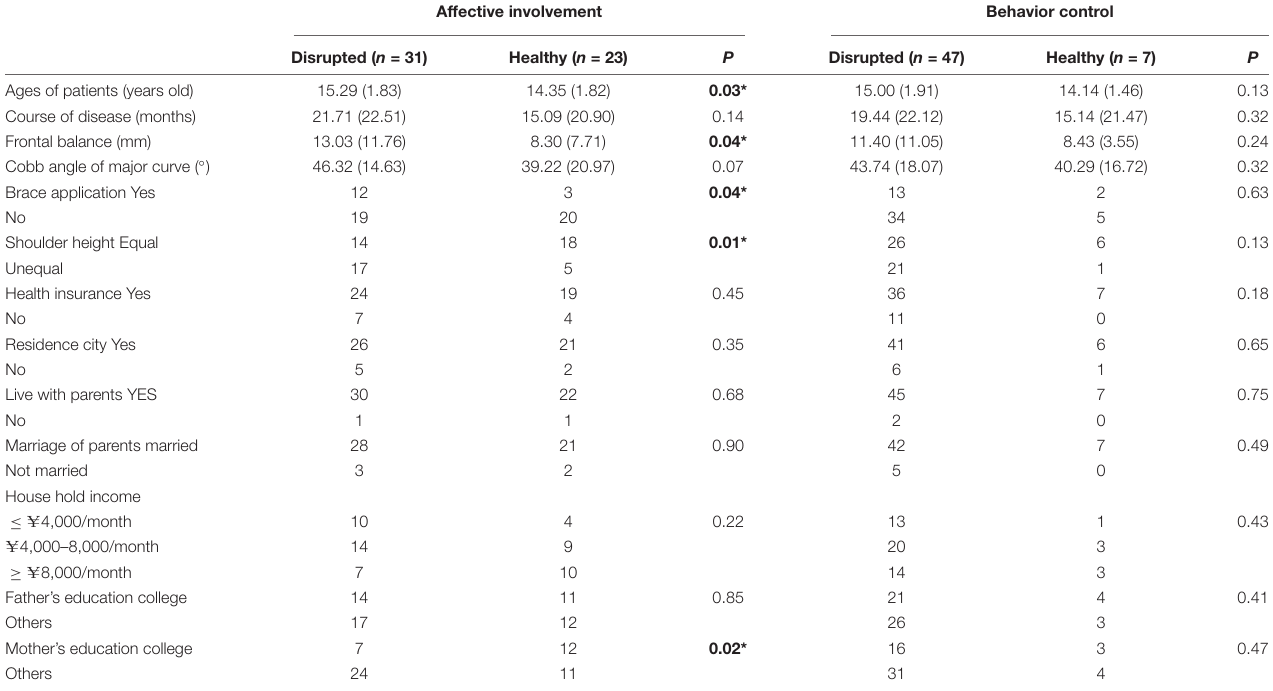
TABLE 2 | Risk factors of AIS families in affective involvement and behavior control subscales disrupting. Affective involvement Behavior